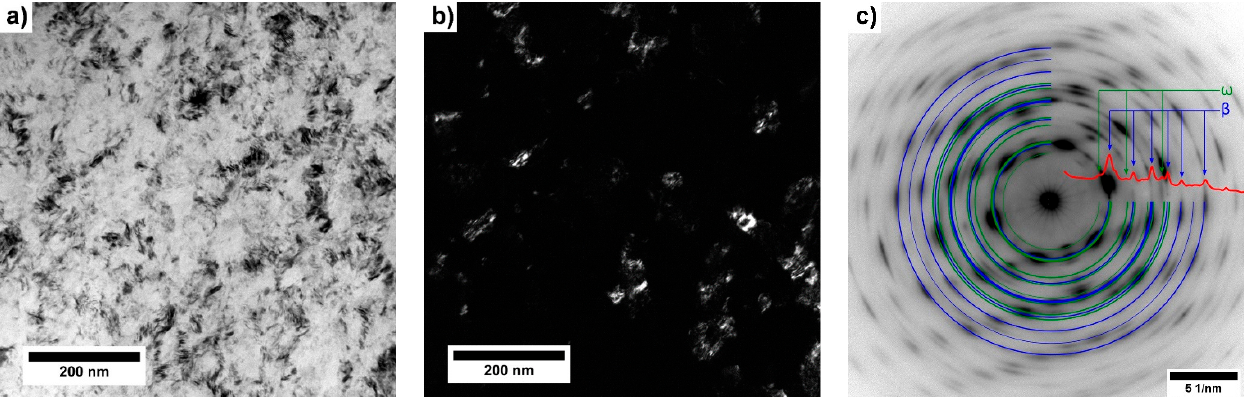
Figure 1. ( a ) TEM bright field image, ( b ) TEM dark field image and ( c ) the corresponding SAED pattern of the material after N = 1 turn of HPT deformation on the peripheral part of the sample. The dark field image was obtained from an arbitrarily selected part of the diffraction rings shown in Figure 1c.